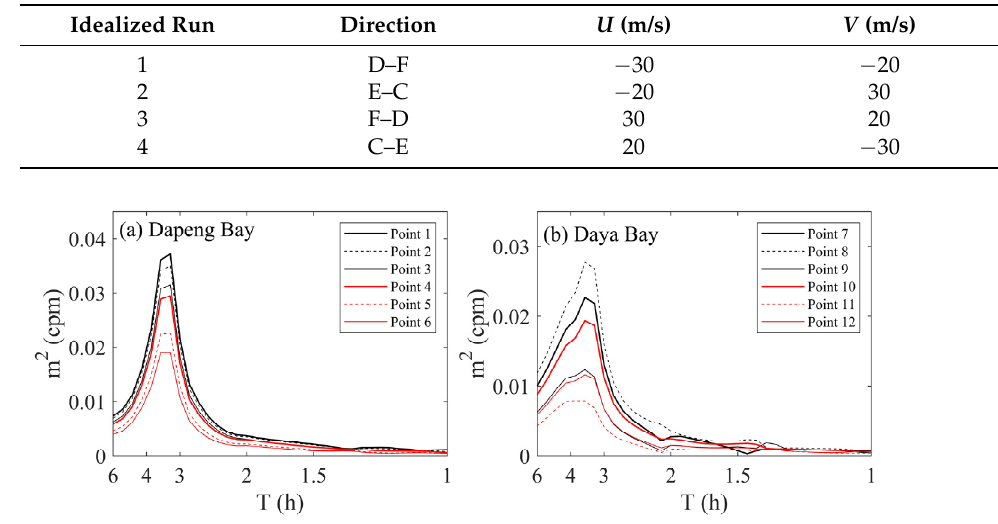
Figure 11. As in Figure 10 in ( a ) Dapeng Bay and ( b ) Daya Bay, except the direction of constant wind forcing is in the D–F direction.